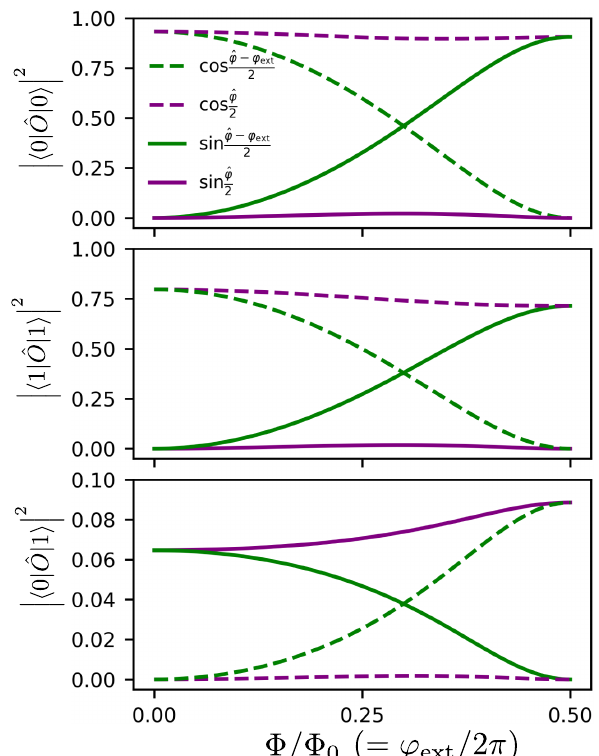
FIG. 5. The qubit matrix elements for single-charge-tunneling as a function of the flux through the SQUID loop, with (cid:5)/(cid:5) 0 = / 2 π . The upper, middle, and lower panels correspond to ϕ ext matrix elements between plasmonic eigenstates 0 ↔ 0, 1 ↔ 1, and 0 ↔ 1. The green (purple) lines correspond to the matrix elements for single-charge tunneling across the JJ with E J 1 ≈ 2.5 GHz ( E J 2 ≈ 8 GHz).